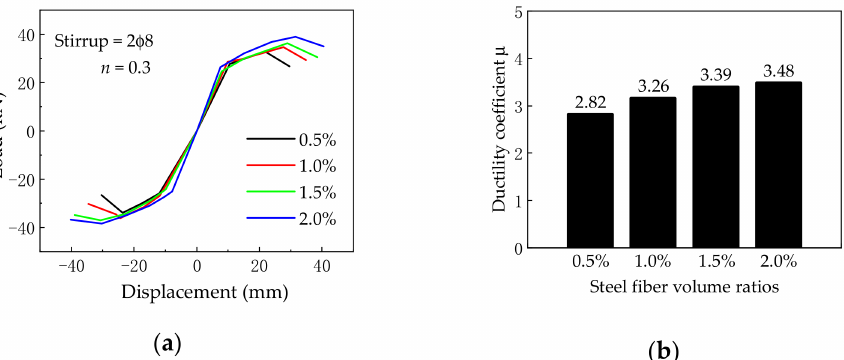
Figure 16. ( a ) Skeleton curves and ( b ) ductility coefficient under different steel fiber volume ratios.